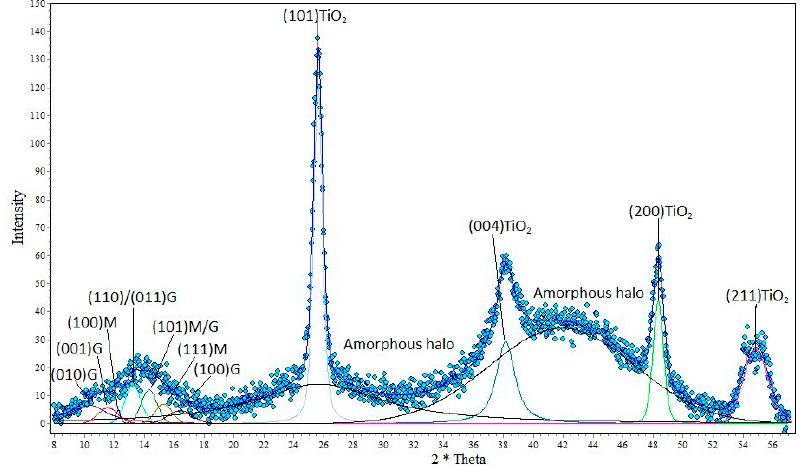
Figure 3. Distribution of the di ff raction curve of calcium alginate fibers containing 7% titanium